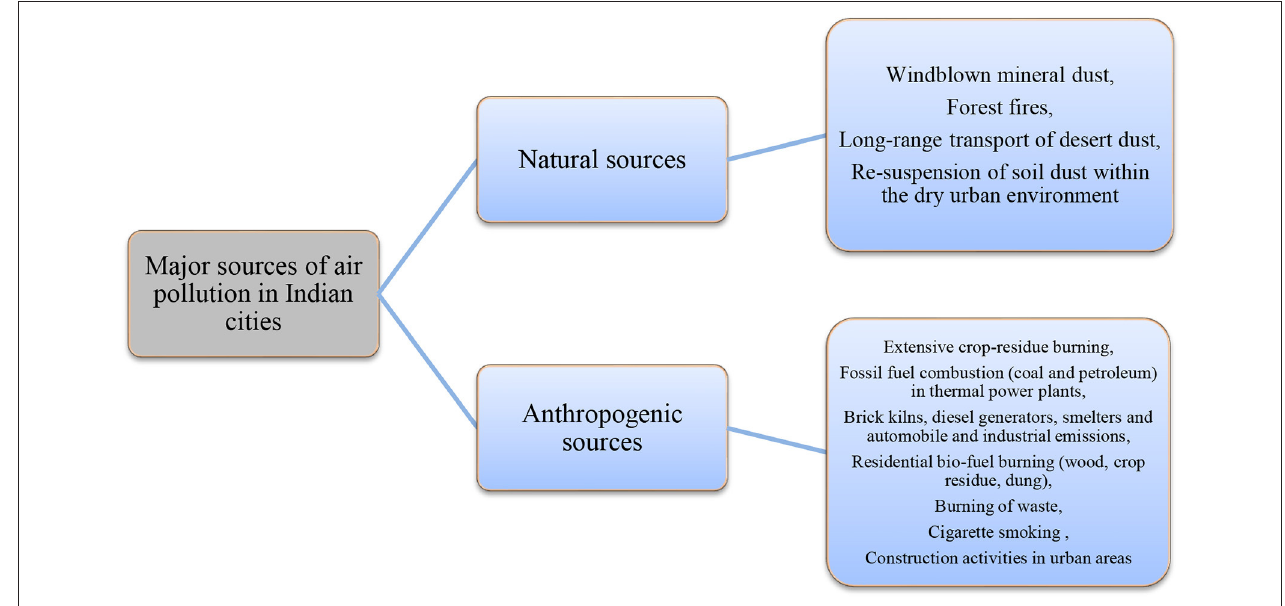
FIGURE 1 | Major sources of air pollution in Indian